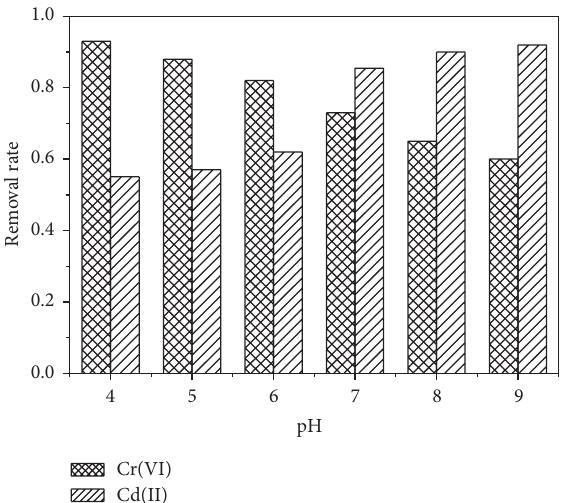
Figure 7: Impact of interfering substance on Cr(VI) and Cd(II) removal capacity by Fe@SiO 2 . Initial Cr(VI) and Cd(II) concen- tration: 70 mg ⋅ L −1 , the Fe dose: 0.15g ⋅ L −1 , pH = 6.0 ± 0.1 , and temperature: 25 ∘